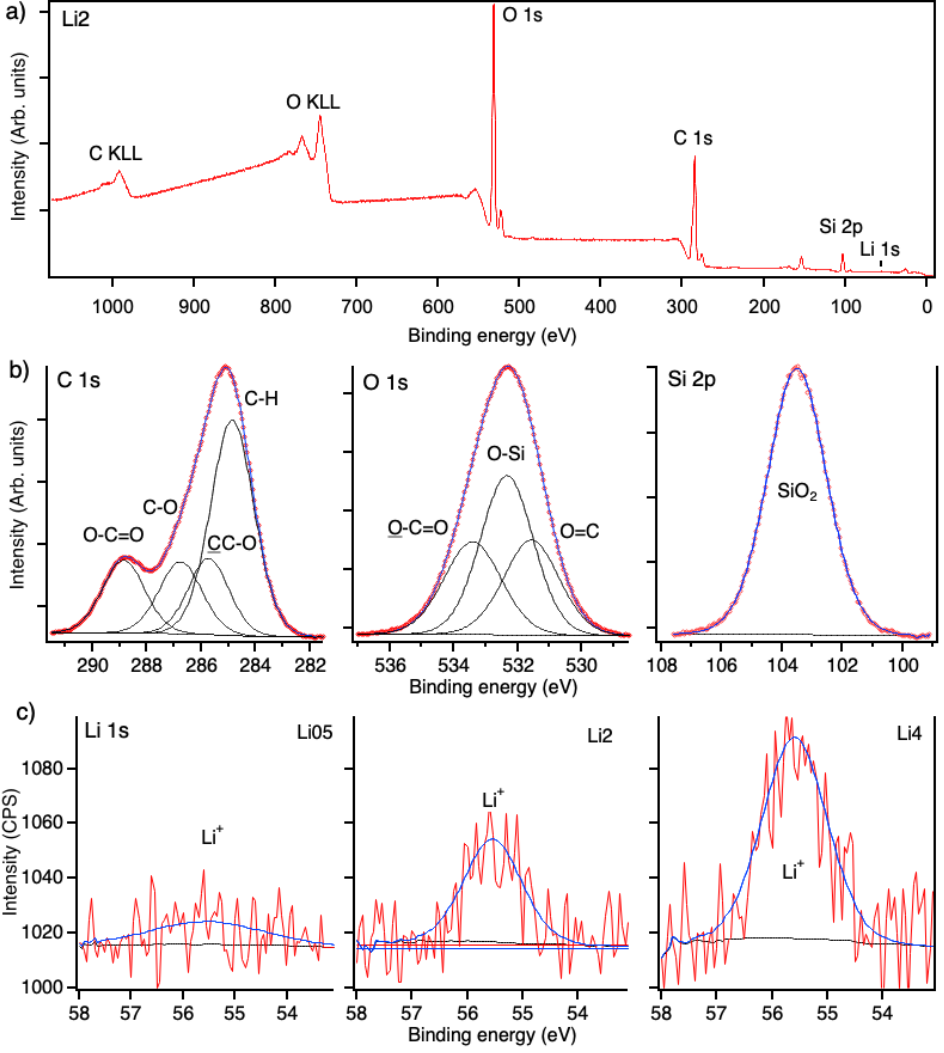
Figure 2. XPS spectra of PMMA–silica–Li coatings ( a ) Li2 survey scan, ( b ) deconvoluted C 1s, O 1s, Si 2p spectra of the Li2 sample, and ( c ) and fitted Li 1s spectra obtained for films with different Li concentrations.